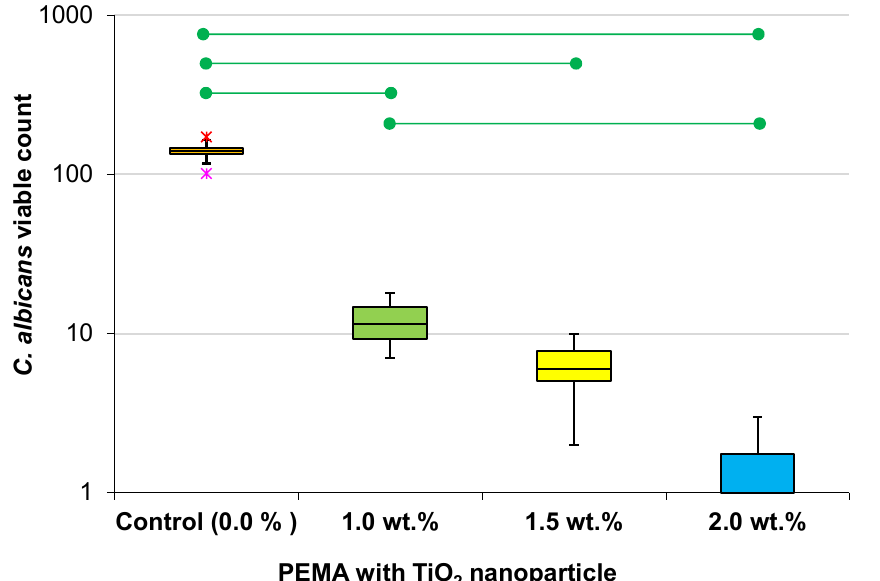
Figure 7. Box plot of the C. albicans viable count for different PEMA-TiO 2 nanoparticle groups and the control group (pure PEMA). A horizontal line connecting two groups indicated a statistically significant difference.